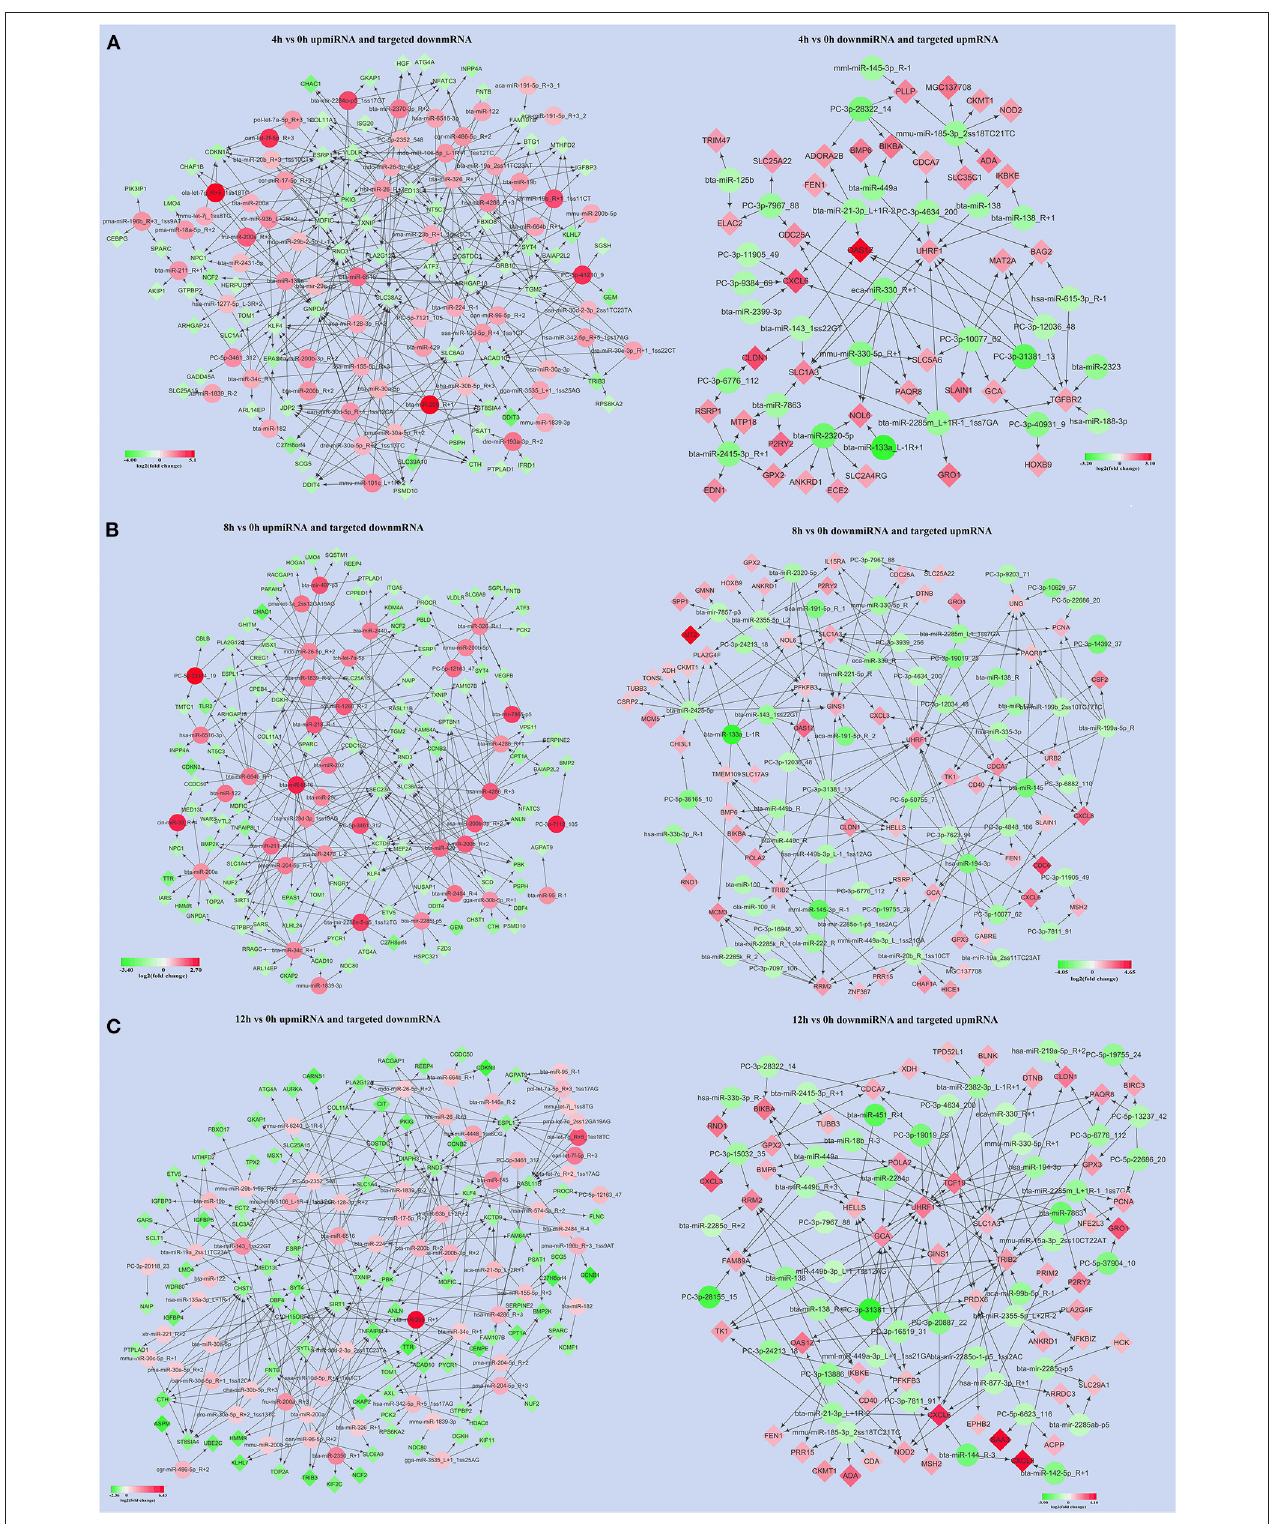
FIGURE 5 | The significantly up/downregulated miRNAs along with significantly down/upregulated targeted mRNAs were screened out at 4, 8, and 12h LPS-induced bMECs compared to 0h, respectively. (A) The results were at 4h; (B) the results were at 8h; (C) the results were at 12h. Green represents downregulation and red represents